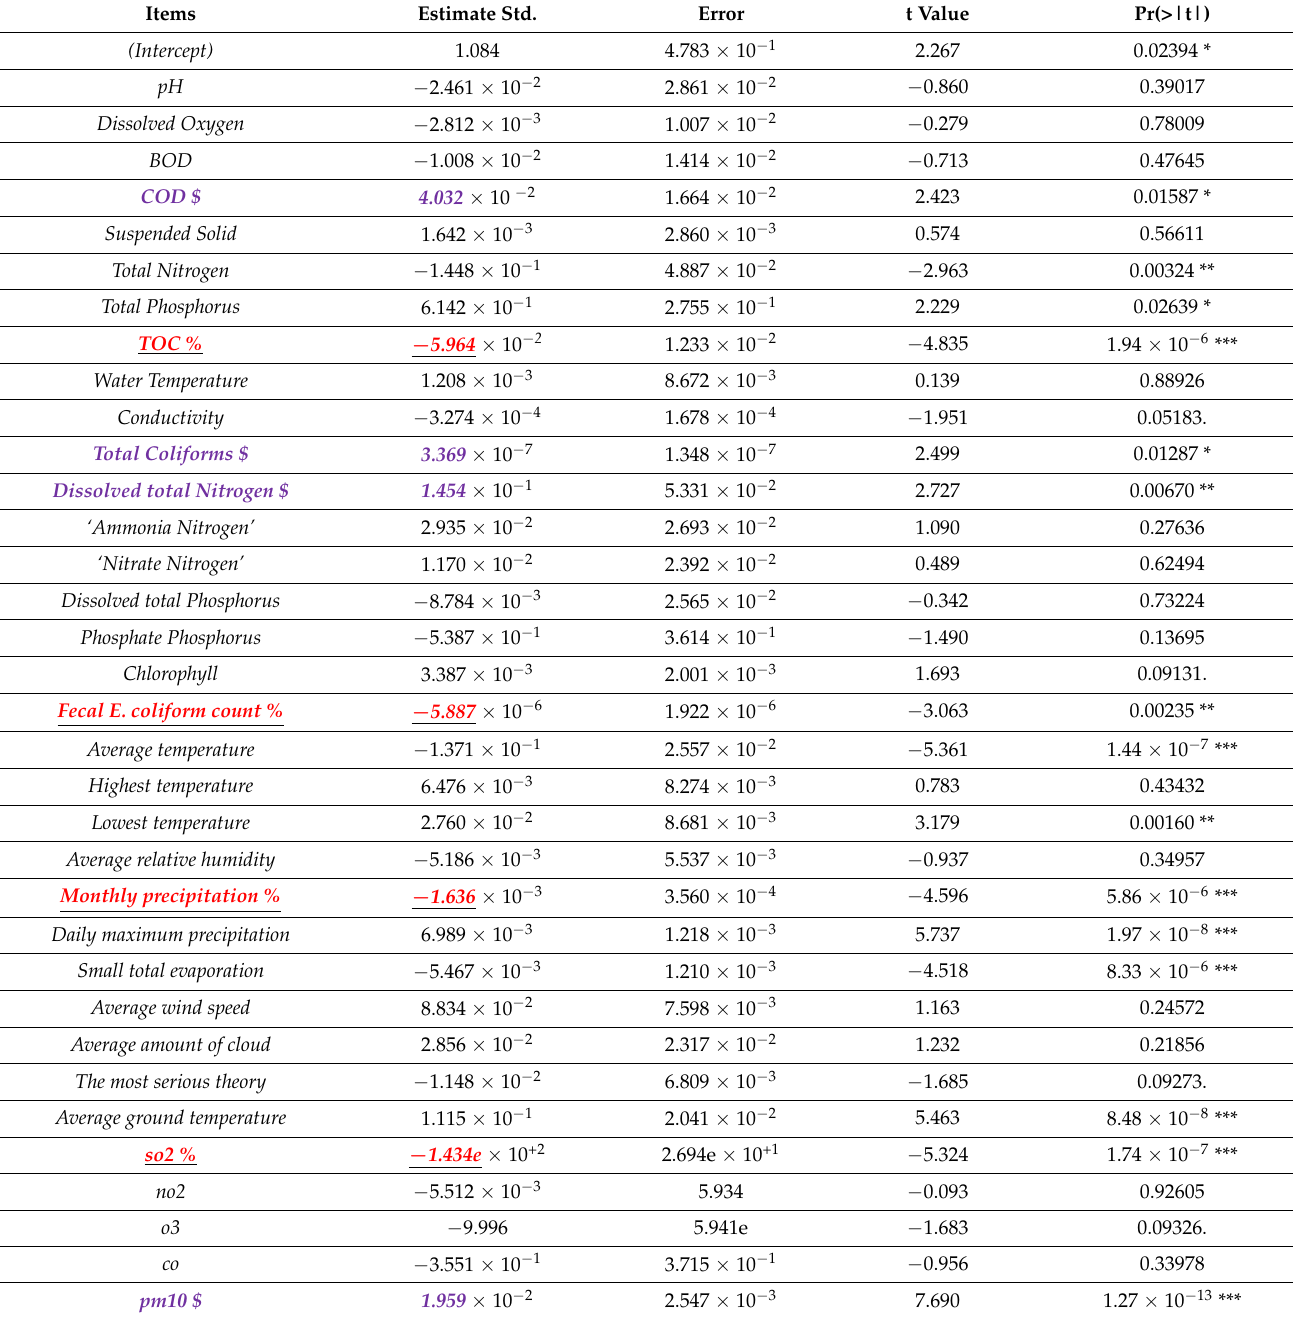
name, in Table 5. The negative correlations for the TOC (Total Organic Carbon) values, number of Fecal E. coliform, monthly precipitation, and so2 are presented in italic, bold, underlined red characters, with a % indicator after the item name, in Table 5. Figure 5 shows the statistical results of the linear hypothesis between hepatitis A and the environmental factors. As a result of the test, the differences between the two groups were interpreted as statistically significant. Table 5. Multiple regression analysis results of each environmental factor and hepatitis